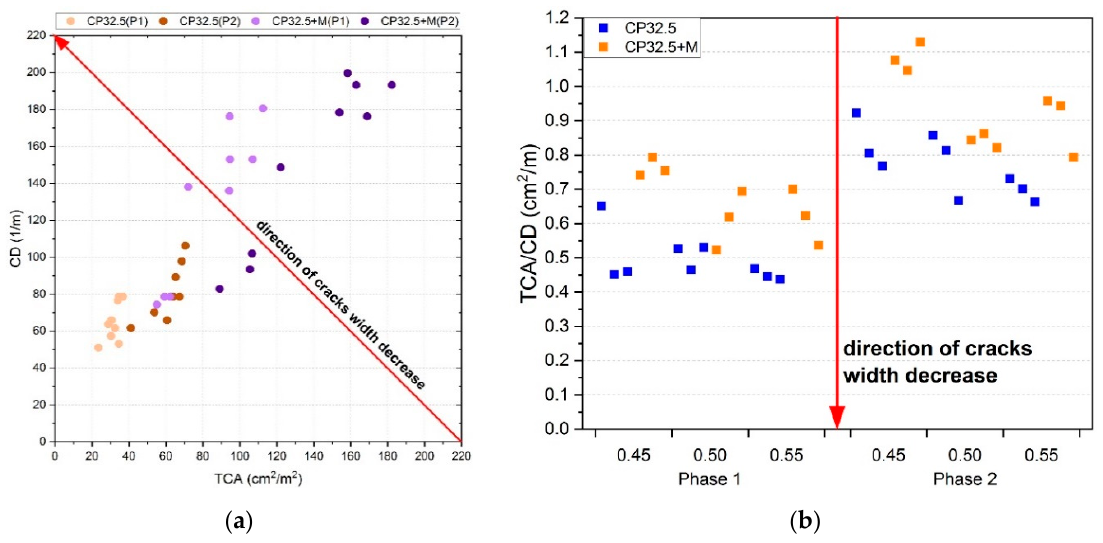
Figure 8. The relative opening width of the crack described as: ( a ) CD(TCA) function; ( b ) TCA / CD ratio; for series designation: (P1)—after the first phase of the thermal load; (P2)—after the second phase of the thermal load.